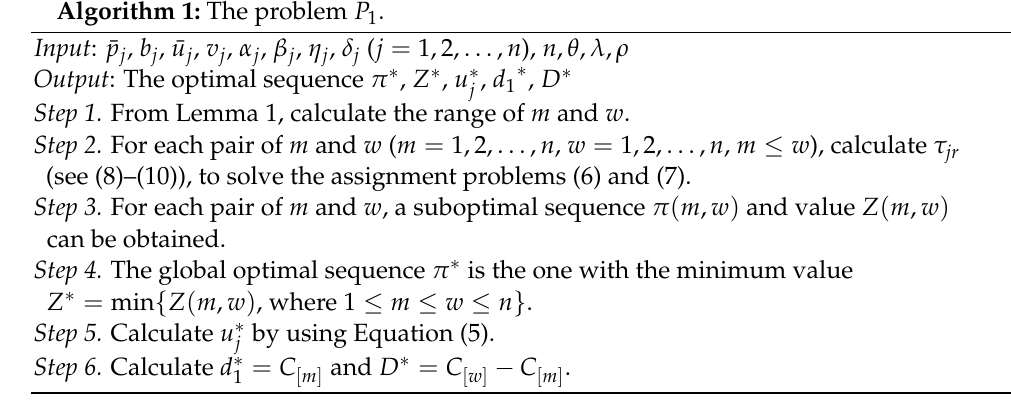
Algorithm 1: The problem P 1